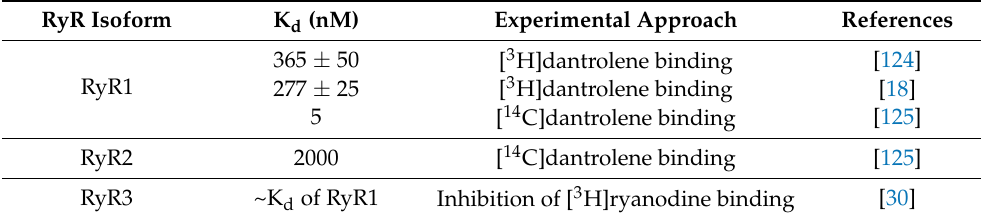
Table 2. The values of dissociation constant for dantrolene binding to the RyR isoforms. RyR Isoform K d (nM) Experimental